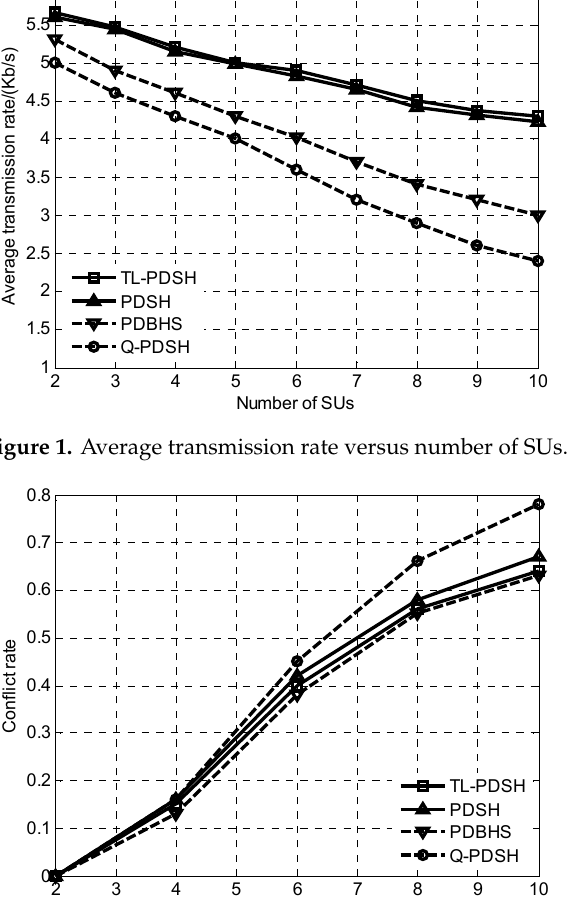
Figure 1. Average transmission rate versus number of SUs.